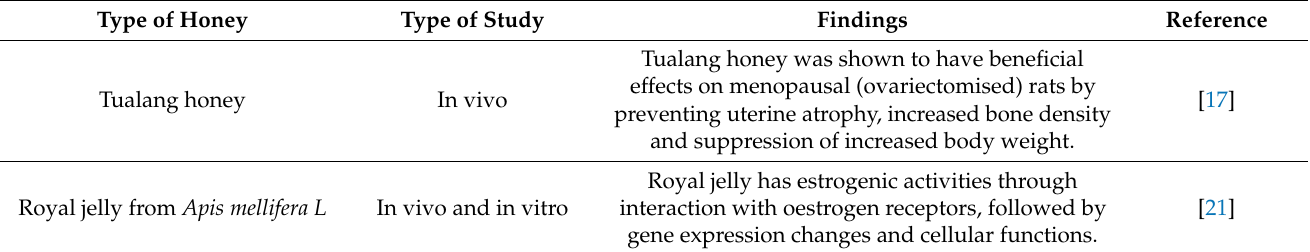
Table 2. Summary of the roles of honey in improving postmenopausal symptoms. Type of Honey Type of